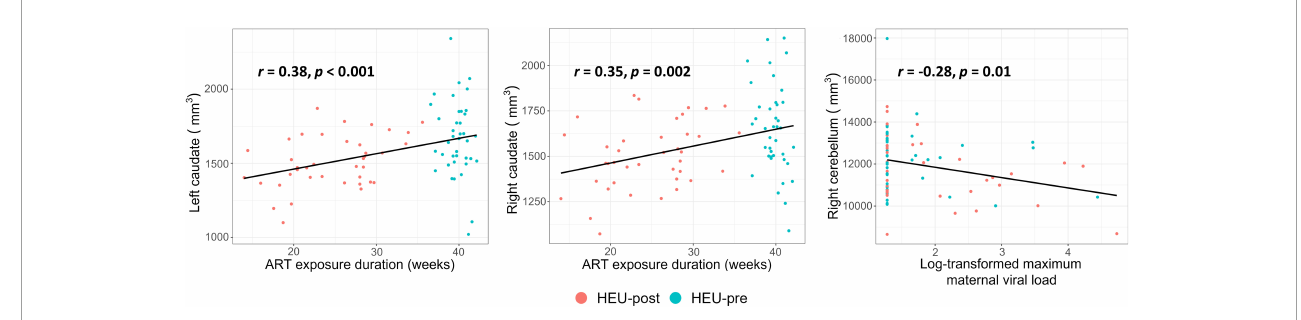
FIGURE4 Plots showing associations of regional volumes with maternal clinical and treatment variables among infants who were HIV-exposed but uninfected. All associations shown remained significant after control for potential confounding variables.